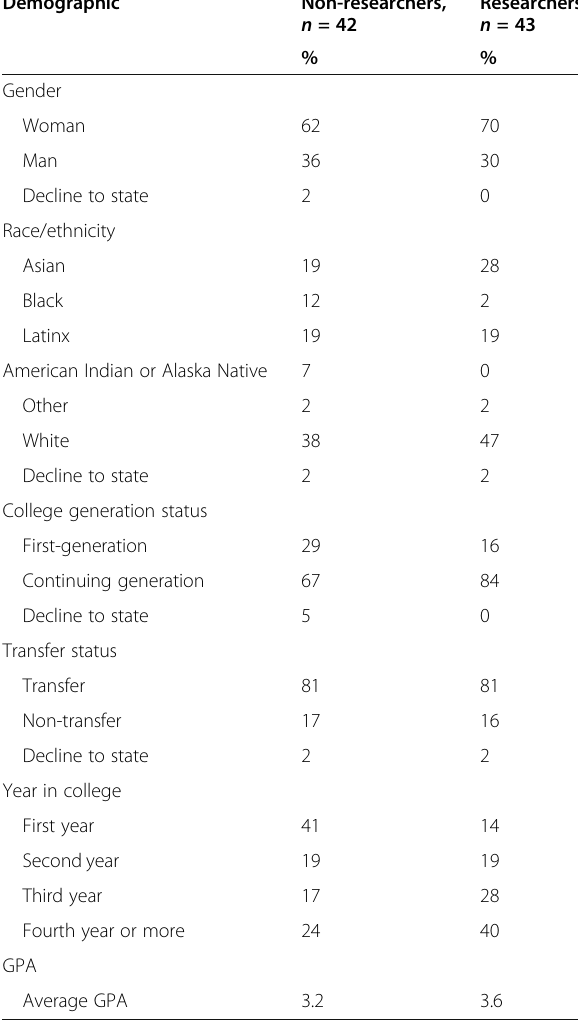
Table 1 Demographics of researchers and non-researchers who participated in the interviews